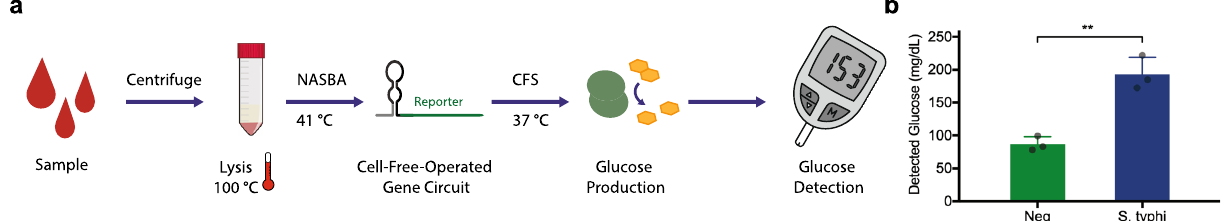
Fig. 4 Detection of S. typhi using the STY-speci fi c toehold switch. a Schematic of the work fl ow used for detection of S. typhi from serum-containing mock samples (7% FBS). b Detection of S. typhi cells using this work fl ow from the serum-containing input with 10 3 CFU/mL. Typh switch at 1.25 ng/ µ L. ** p = 0.0097. Data presented is the mean of N = 3 independent experiments (as indicated by dot plots) ±SD Source data are provided as a Source Data fi